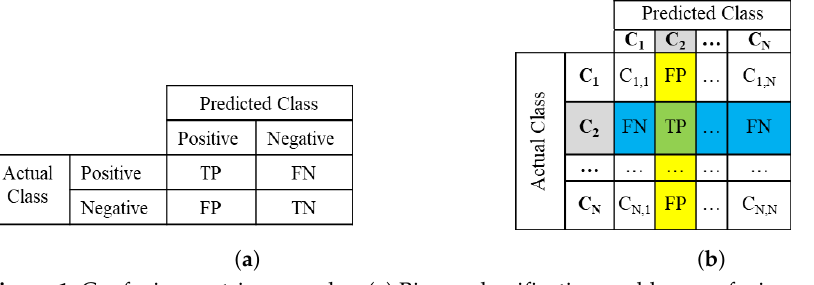
Figure 1. Confusion matrix examples. ( a ) Binary classification problem confusion matrix. ( b ) Multi- class classification problem confusion